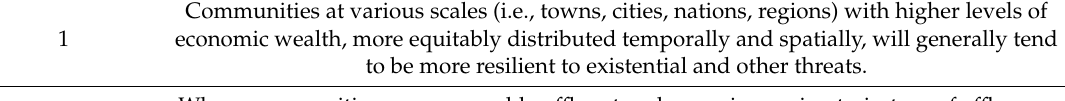
Table 1. Impacts of the pandemic